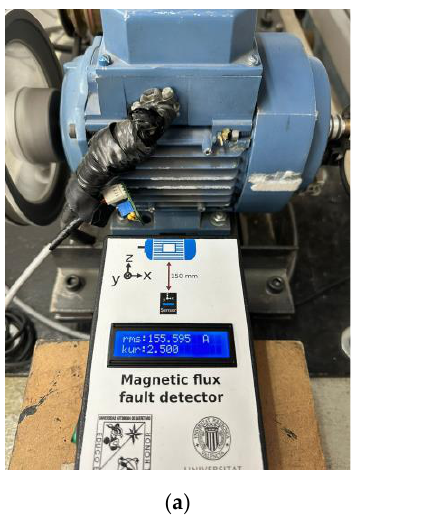
Figure 8. ( a ) SMFFD performing an online fault diagnosis on the induction motor with the healthy bearing; ( b ) observing the results in detail through the digital zoom on the LCD screen.